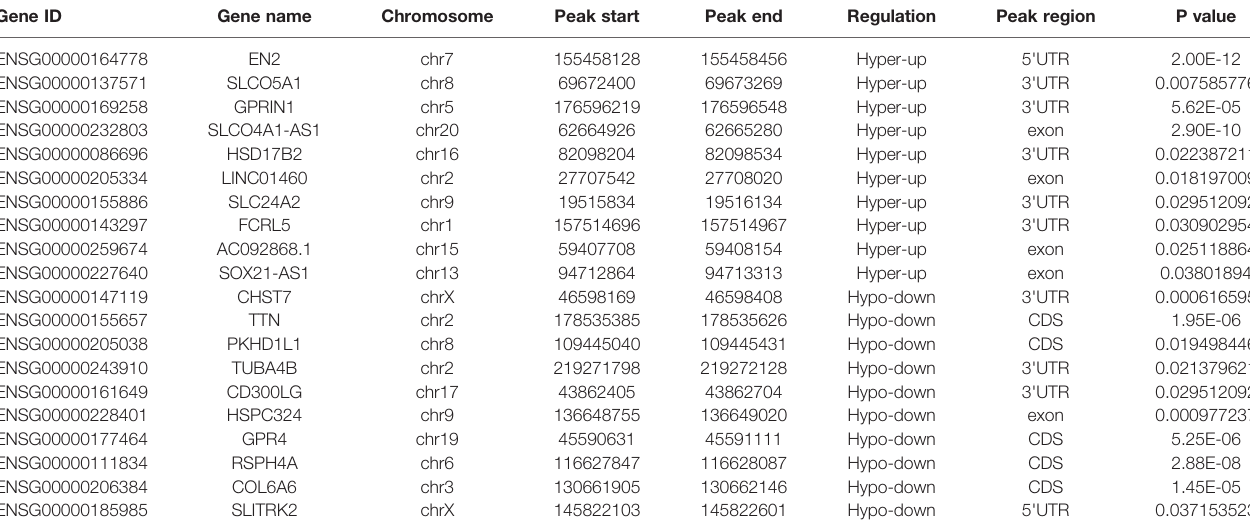
TABLE 2 | Top 20 differently genes in m6A-seq&RNA-seq (Tumor/Normal).